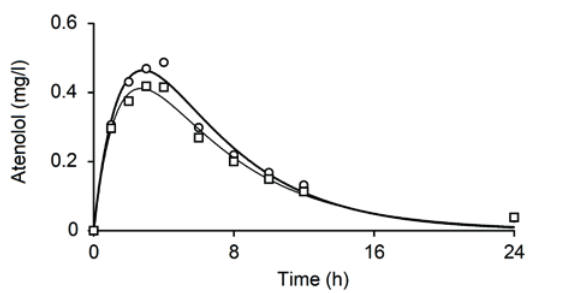
Figure 2. Concentration-time profile of atenolol administered separately and in combination with valsartan by PK model. Squares–measured concentration of atenolol administered separately; circles–measured concentration of atenolol administered in combination with valsartan; line–model approximation.